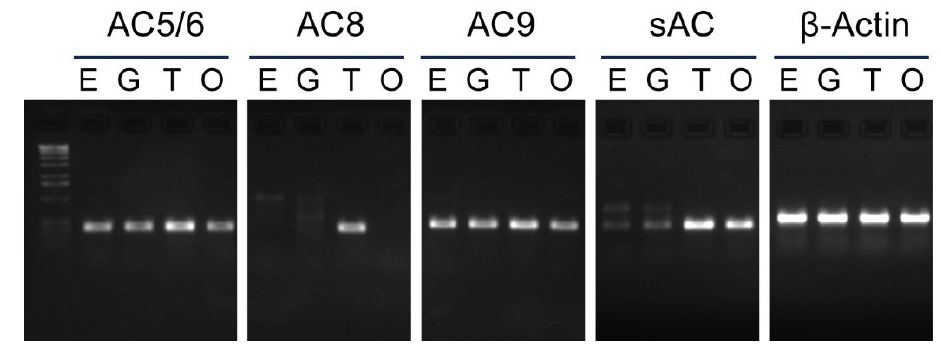
Figure 2. Tissue expression patterns of the adenylyl cyclase ( AC ) genes in Ciona tissues. RT-PCR analysis of mRNA from several adult Ciona tissues shows that genes encoding all AC isoforms are expressed in testis but the expression of AC8 is testis-specific. Expression of sAC gene was found in testis and ovary. β -actin was used as an internal control. E, endostyle; G, gill; T, testis; and O,